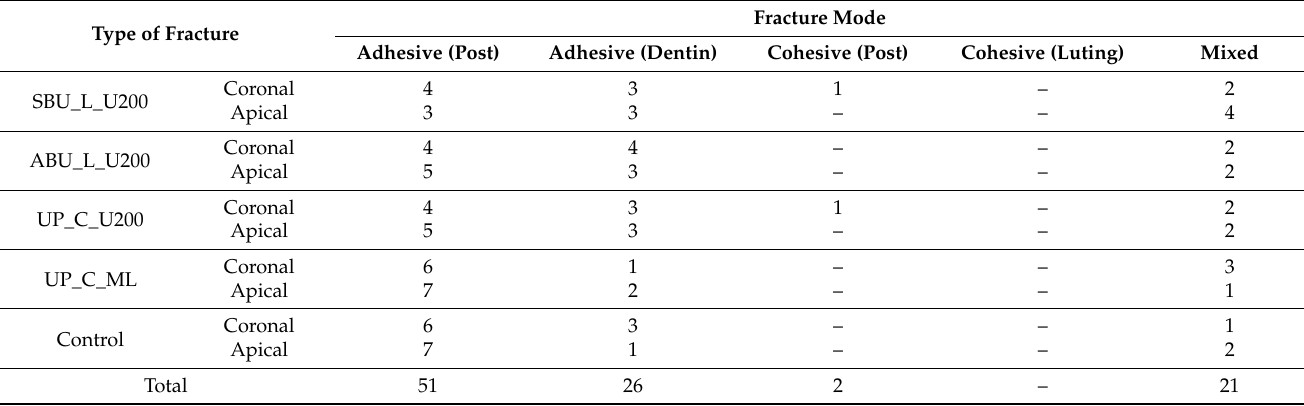
Table 4. Fracture modes at the coronal and apical parts in each